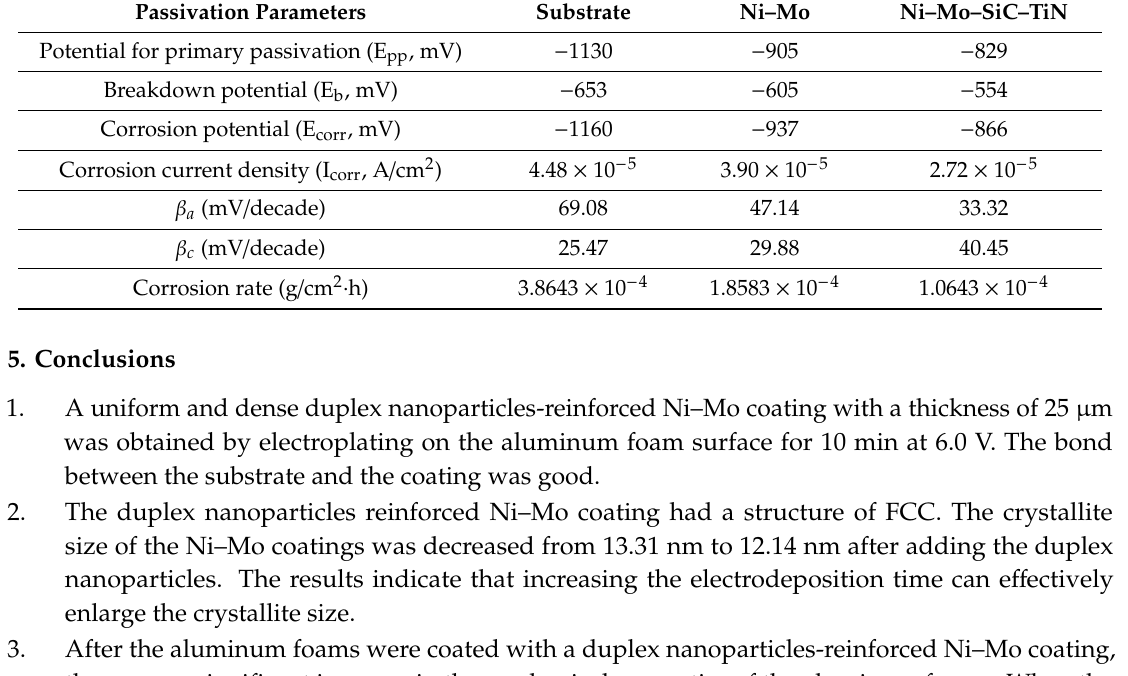
Table4. Thecorrosionparametersextractedfromthepolarizationcurvesandweightlossvs. timecurves. Passivation Parameters